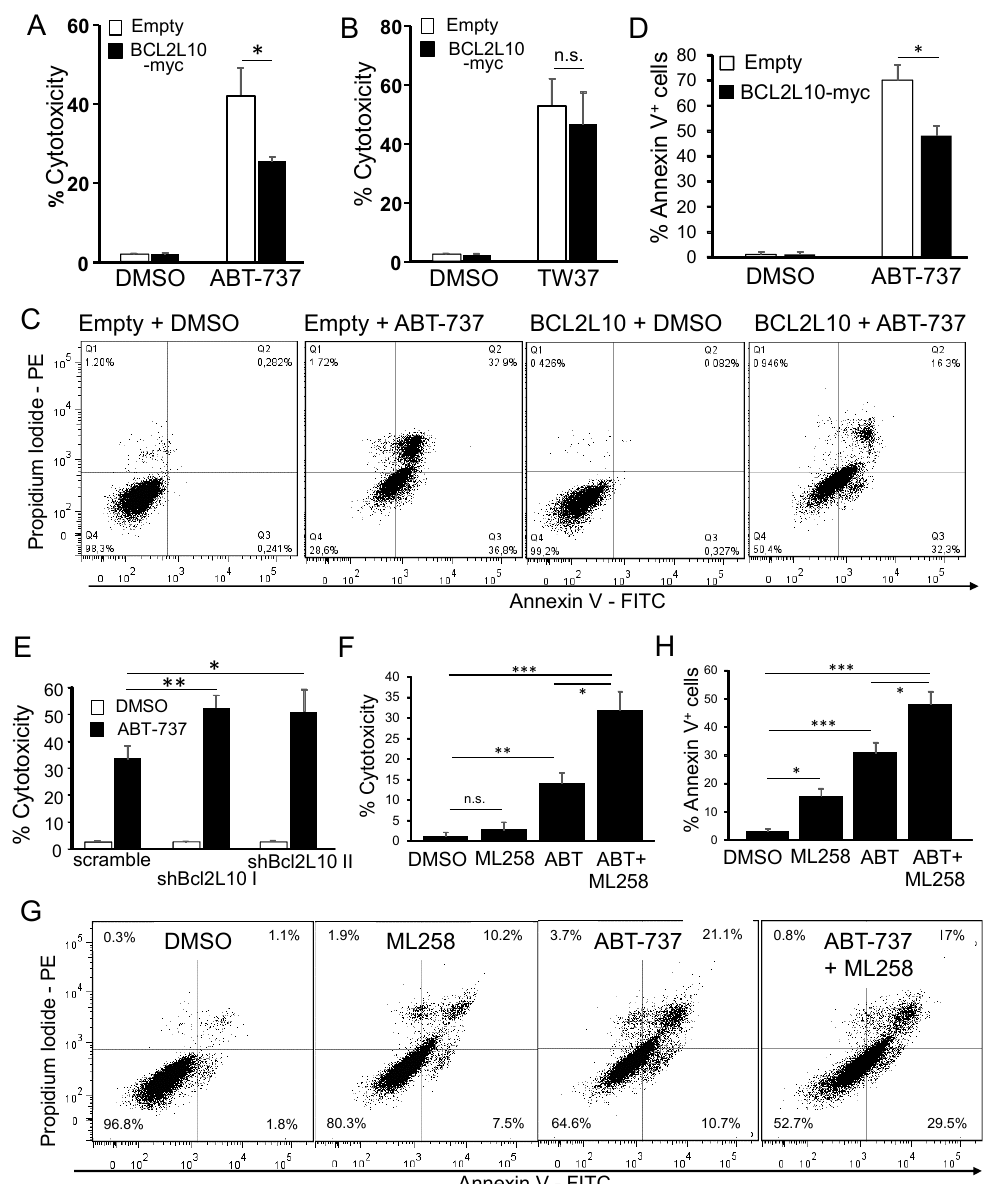
Figure 6. BCL2L10 promotes resistance to ABT-737. ( A , B ) M2-empty and M2-BCL2L10-myc cells were treated with 10 µ M ABT-737 ( A ) or 5 µ M TW-37 ( B ) for 48 h. Bar graph shows the mean ± SD ( n = 4 for cisplatin and n = 5 for TW-37) of the percent of cytotoxicity. ( C ) M2-empty and M2-BCL2L10-myc cells were treated with 10 µ M ABT-737 for 24 h, stained with PI/annexin V and analyzed by flow cytometry. Representative histograms are shown. ( D ) Bar graph shows the mean ± SD ( n = 3) of the percentage of annexin V positive cells from the experiment in ( C ). * p < 0.01. ** p < 0.001, ns: not significant, n = 3. ( E ) A375-scramble and A375-shBCL2L10 cells were treated with ABT-737 (10 µ M). Bar graph shows the mean ± SD (from three independent experiments) of the percent of cytotoxicity. ( F ) A375 cells were treated with ABT-737 (2.5 µ M), ML258 (10 µ M) or ABT-737 plus ML258 (same concentrations) and the percent of cytotoxicity was determined by using a crystal violet cytotoxicity assay. Bar graph shows the mean ± SD (from three independent experiments) of the percent of cytotoxicity. *: p < 0.05, n = 3. ( F ) A375 cells were treated with ABT-737 (2.5 µ M), ML258 (10 µ M) (alone or in combination) Bar graph shows the mean ± SD ( n = 3) of the percent of cytotoxicity. ( G ) A375 cells were treated with ABT-737 (10 µ M), ML258 (40 µ M) (alone or in combination) for 24 h, stained with PI/annexin V and analyzed by flow cytometry. Representative histograms are shown. ( H ) Bar graph shows the mean ± SD ( n = 3) of the percentage of annexin V positive cells from the experiment in ( G ). The statistical analysis is described in the Methods. *: p < 0.05, **: p < 0.01, ***: p < 0.001, ns: not significant, n =